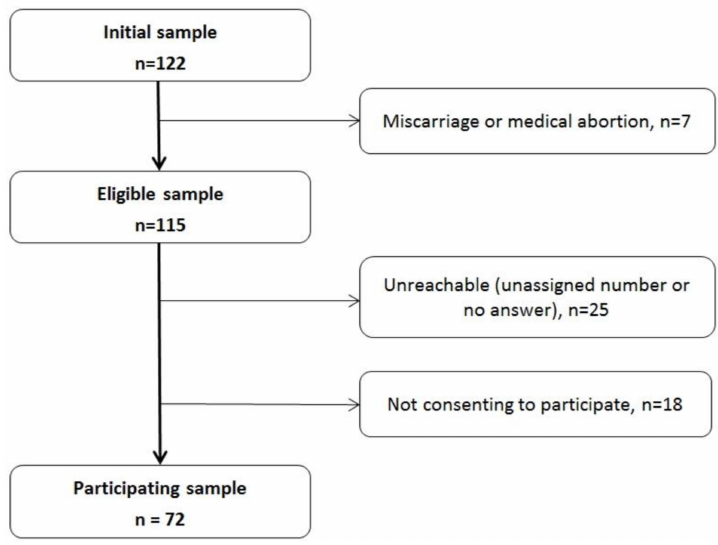
Figure 1. Flowchart of recruitment